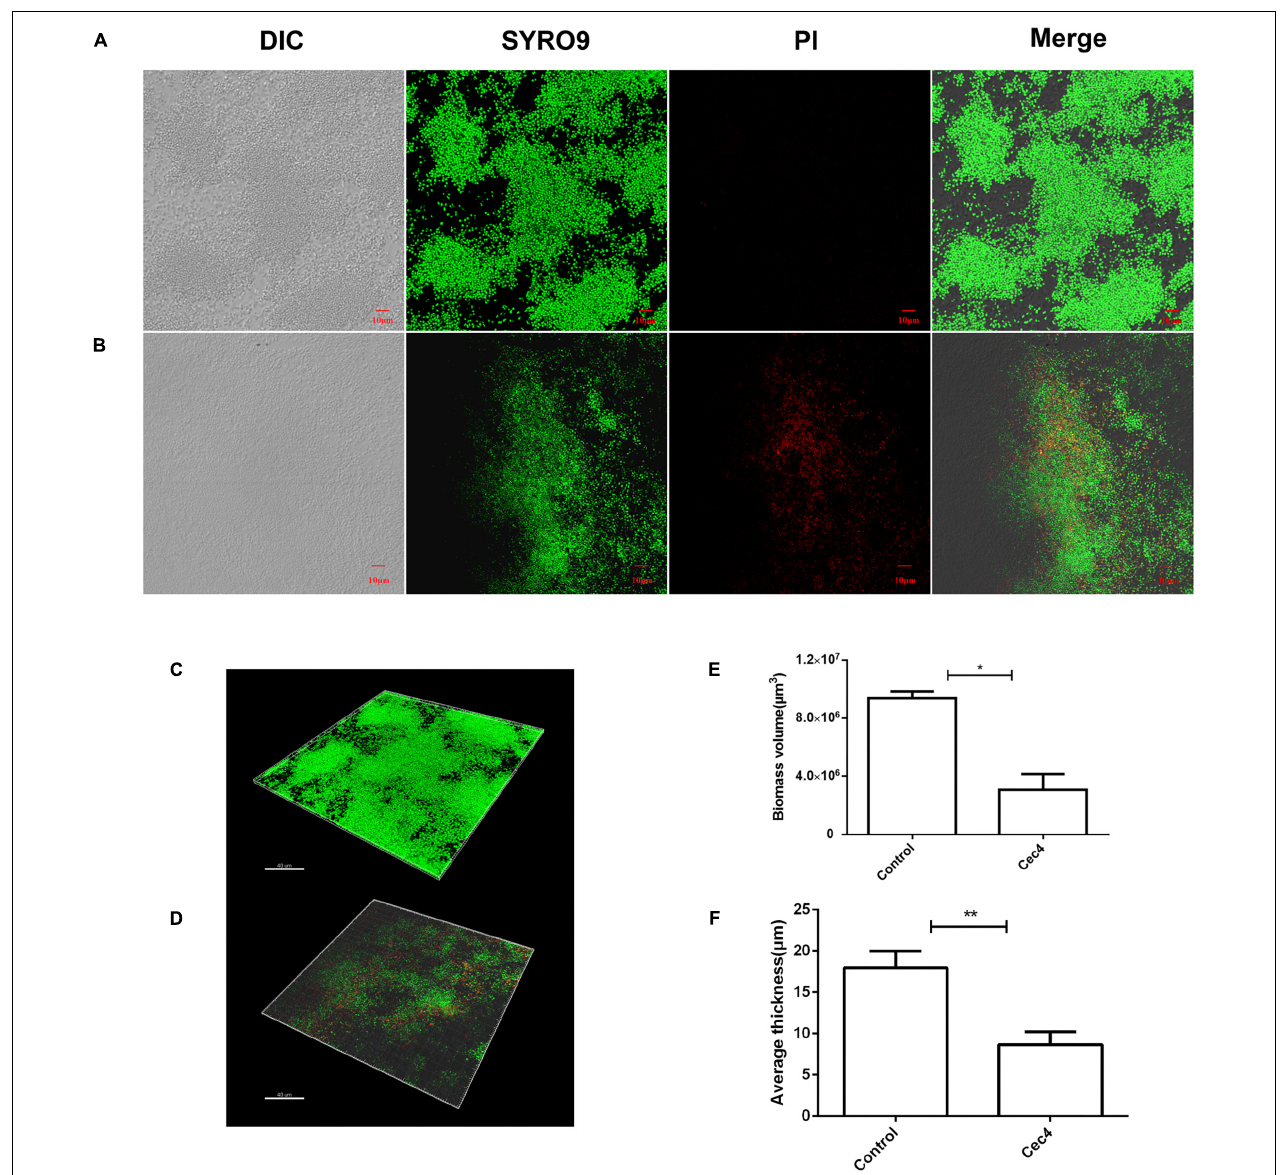
FIGURE 3 | The CRAB biofilm was removed effectively with Cec4. Confocal microscopy of CRAB biofilm without treatment (A) and after treatment with Cec4 (B) . The three-dimensional reconstruction of CRAB biofilm without treatment (C) and after treatment with Cec4 (D) . The total biomass volume (E) and thickness (F) of biofilm were calculated based on the fluorescence intensity. The results were averaged from three randomly selected positions of each sample. Data are expressed as mean ± standard deviation (SD). * p < 0.05; ** p <